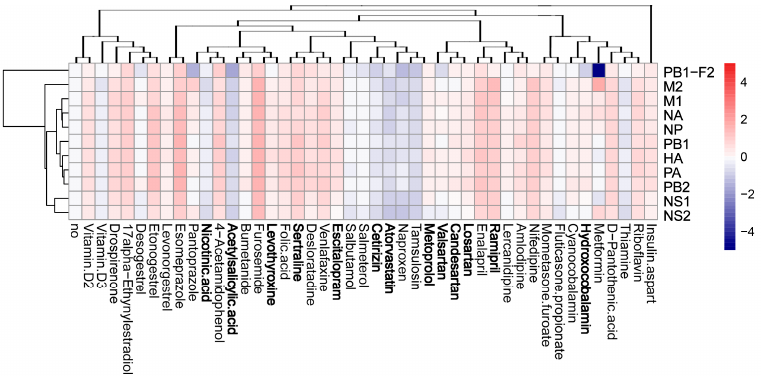
Figure 6. Effect of 45 compounds on polyadenylated viral RNAs in FLUAV-infected RPE cells. RPE cells were treated with 10 μ M compounds or remained non-treated and infected with FLUAV at moi 1. After 8 h, total RNA was isolated, and a fraction of polyadenylated RNA was sequenced. A heatmap of viral RNAs affected by treatment is shown. Rows represent gene symbols, columns represent treatments with drugs, clustered based on structural similarity. Drugs marked in bold are compounds which were predicted to affect FLUAV–host cell interactions. Each cell is colored according to the log2-transformed expression values of the samples, expressed as fold change relative to the non-treated FLUAV-infected control. Viruses 2021 , 13 , x FOR PEER REVIEW